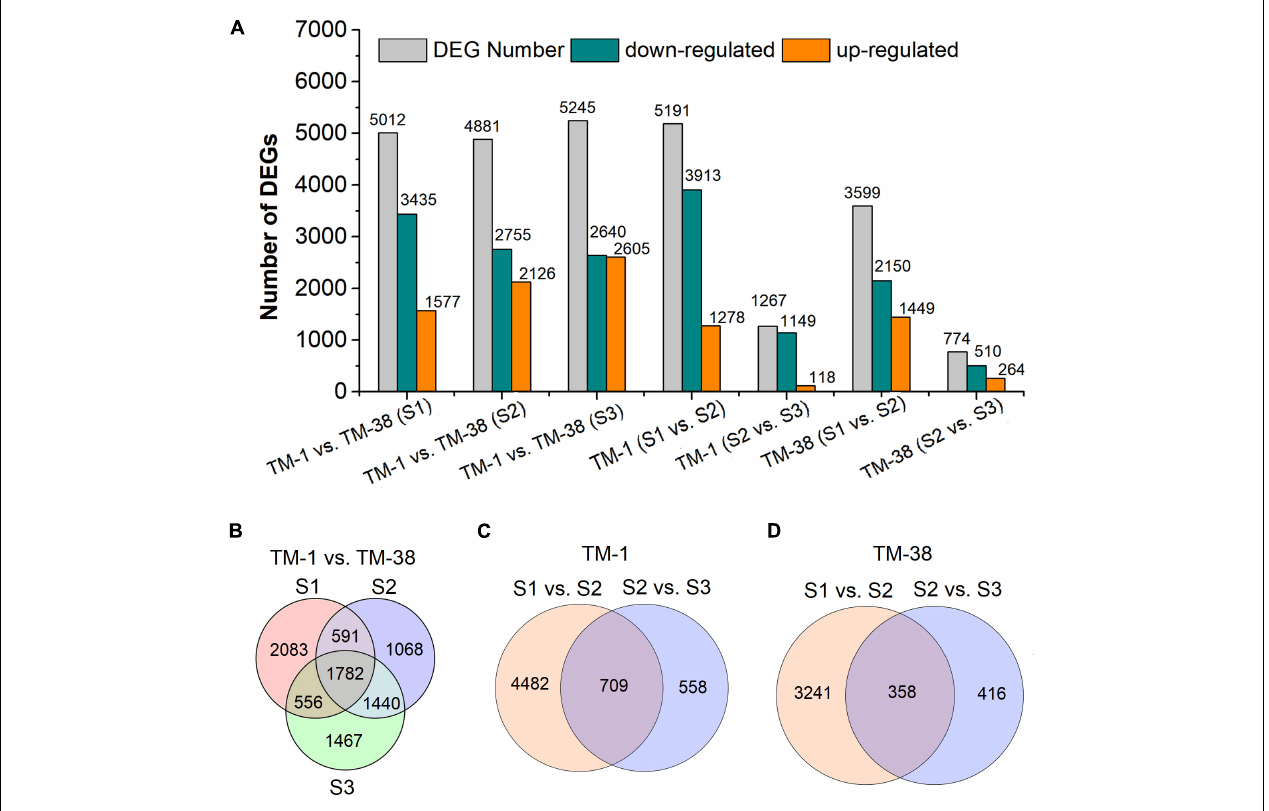
FIGURE 3 | Summary of the number of differentially expressed genes (DEGs) identified by RNA-seq analysis in tomato fruits of TM-1 and TM-38 at three developmental stages. The number of total DEGs, upregulated DEGs, and downregulated DEGs are presented by histograms (A) . The Venn diagrams represents the number of common DEGs shared by TM-1 vs. TM-38 at three developmental stages (B) , S1 vs. S2 and S2 vs. S3 of TM-1 (C) , and TM-38 (D) .